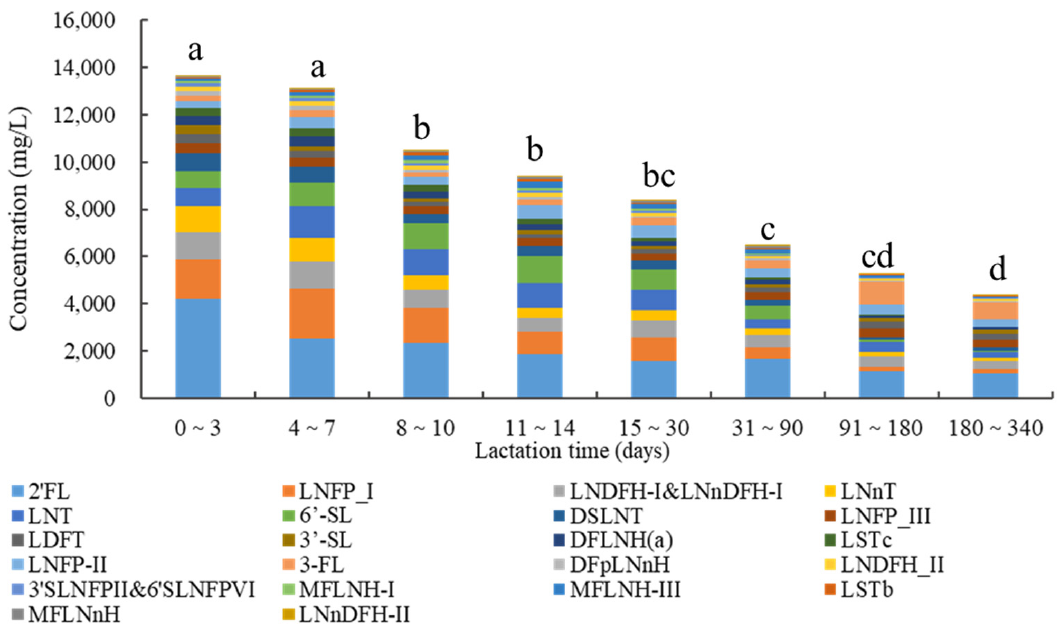
Figure 3. Concentrations of total oligosaccharides at different lactation times. Data are shown as median. Small le tt ers indicate a signi fi cant di ff erence ( p < 0.05).